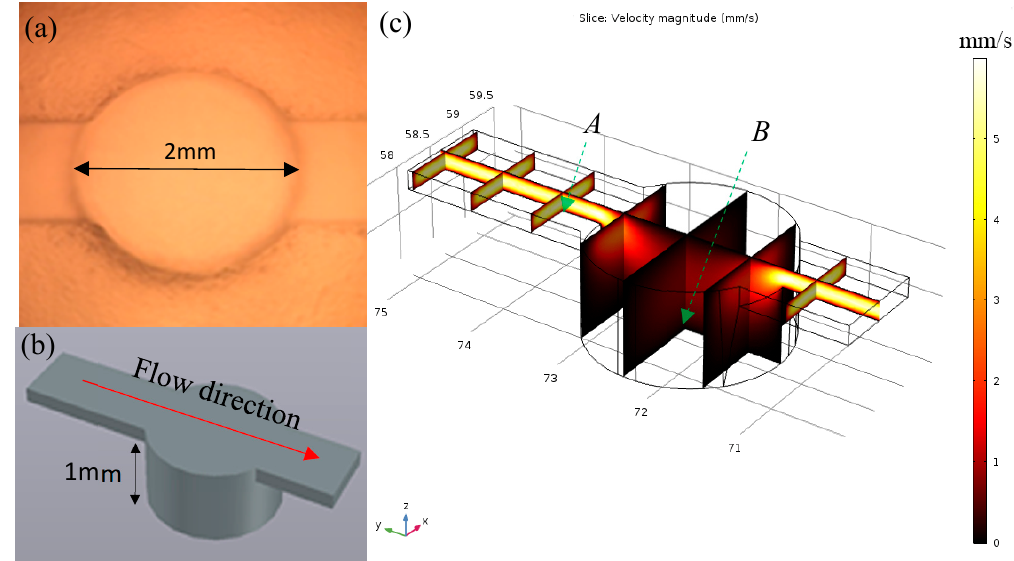
Figure 2. ( a ) Fabricated single well working unit; ( b ) AutoCAD 3D model of well unit; ( c ) COMSOL simulation of the flow rate distribution of the well unit (data were collected at cross-section plane A and B, 10 µm above boundary).